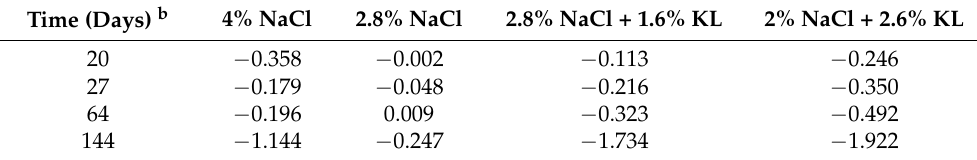
Figure 4. L. innocua growth during ripening and storage of artificially contaminated salami produced with high salt (4% NaCl) and low salt (2.8% NaCl) concentrations alone as well as the two different low NaCl plus KL combinations (2.8% NaCl + 1.6% KL or 2% NaCl + 2.6% KL). Presented is ( A ) growth profiles and ( B ) relative growth increase or decrease quantification of the four L. innocua strain cocktail under the different treatments. Data are mean log CFU counts from two replicates at 0, 1, 2, 4, 7, 9, 13, 16, and 20 days of salami ripening. Day 27, 64 and 114 represent 7, 44 and 94 days of storage at 4 °C. The dotted line denotes the end of salami ripening. * Indicates significant difference between treatments at that time point ( p < 0.05 based on one-way ANOVA and Tukey post-hoc test pairwise comparison of the salami batches). Table 4. Comparison of Listeria growth potential in the different salami batches a .